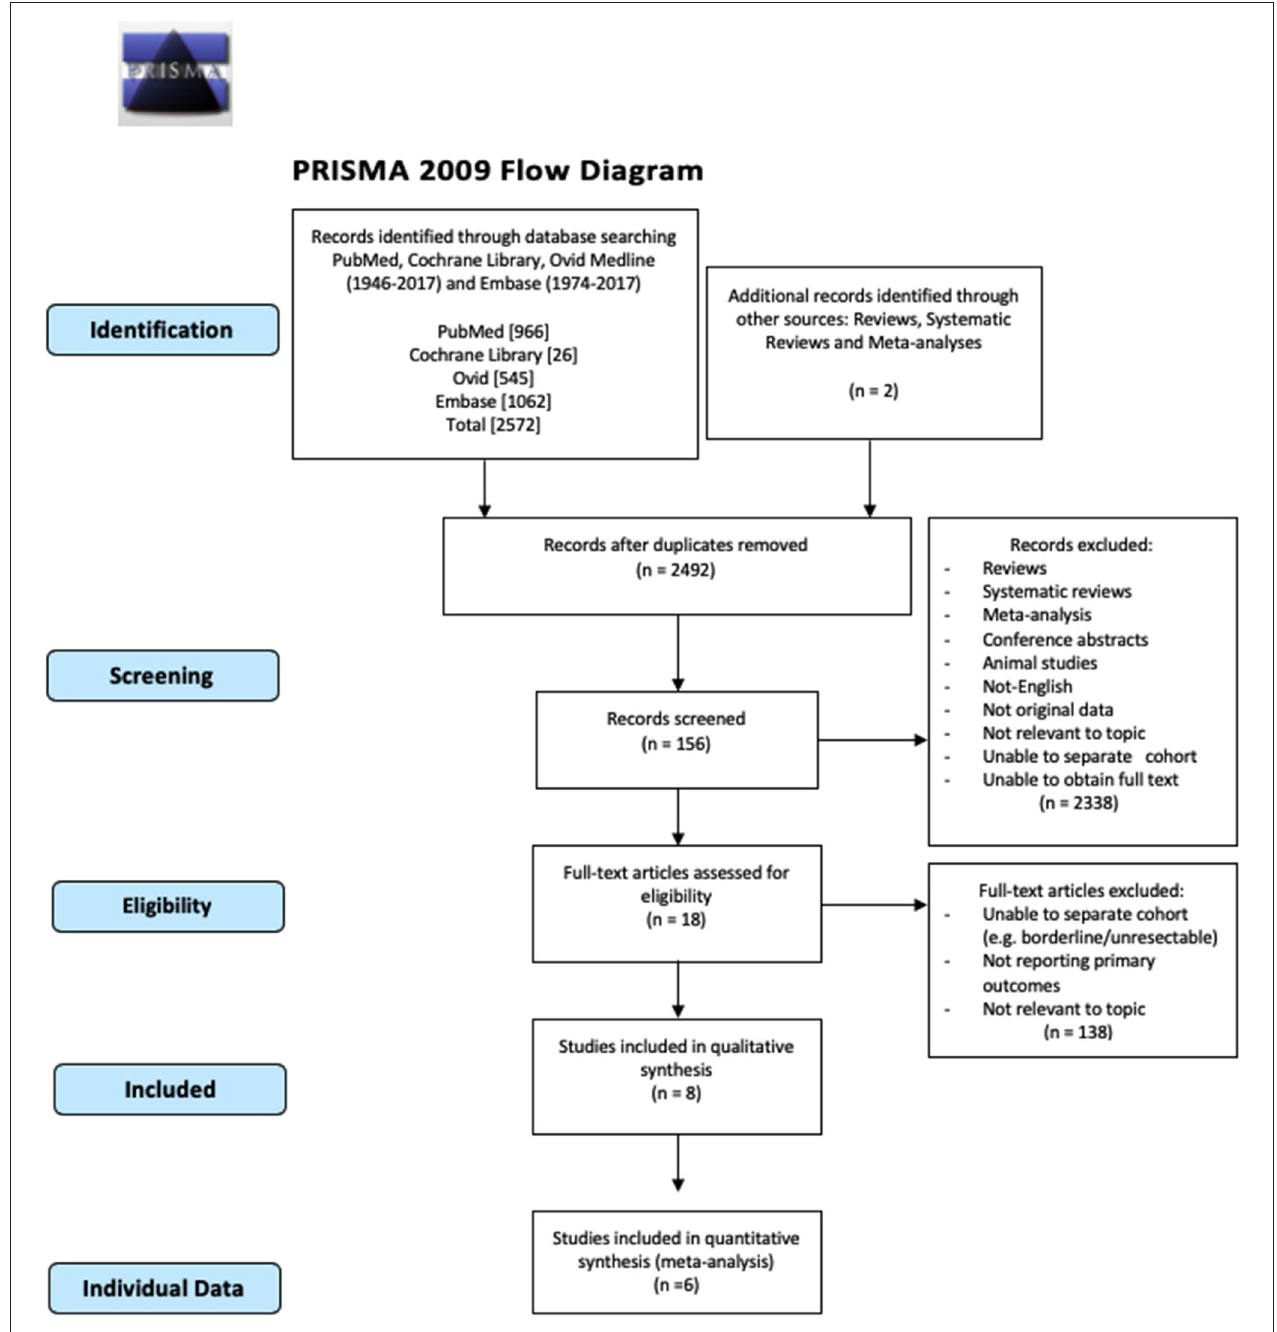
FIGURE 1 | PRISMA 2009 flow